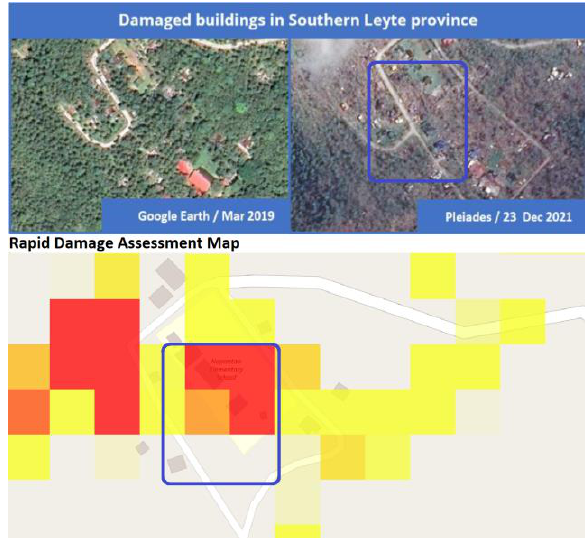
Figure 6. Rapid damage maps at Napantao Elementary School, Southern Leyte. Bounding box shows location where potential damage has been identified by both UNITAR / UNOSAT maps and by SAR-derived damage map. Basemap © OSM